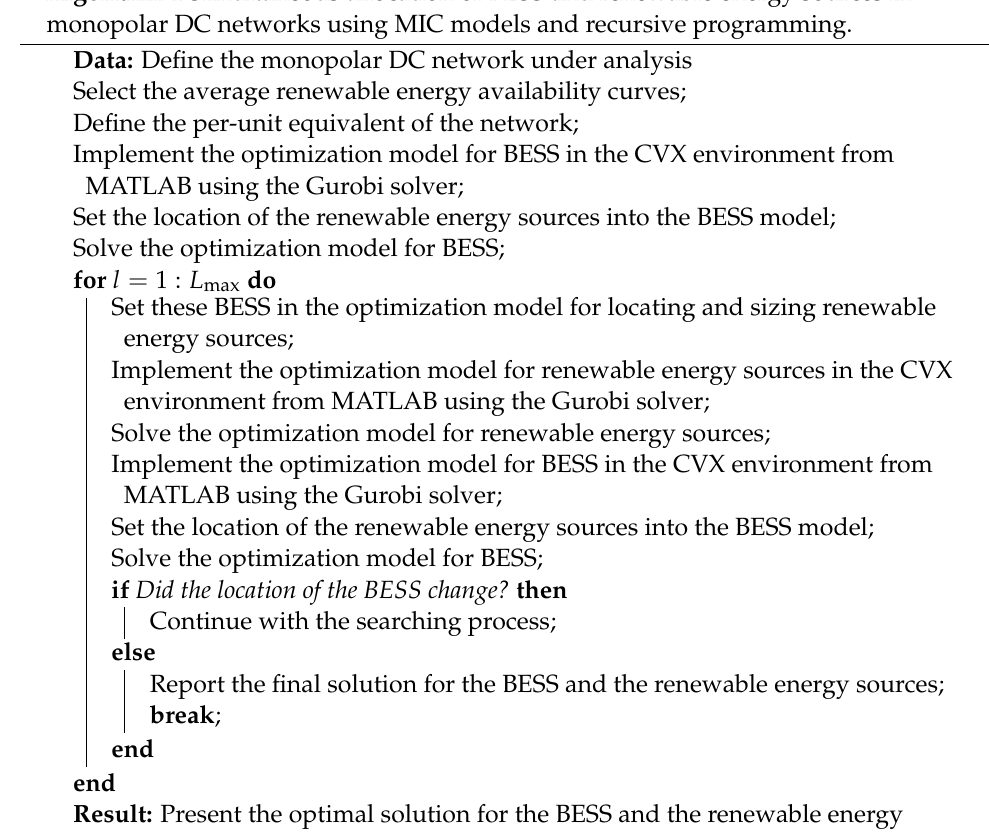
Algorithm 1 Simultaneous allocation of BESS and renewable energy sources